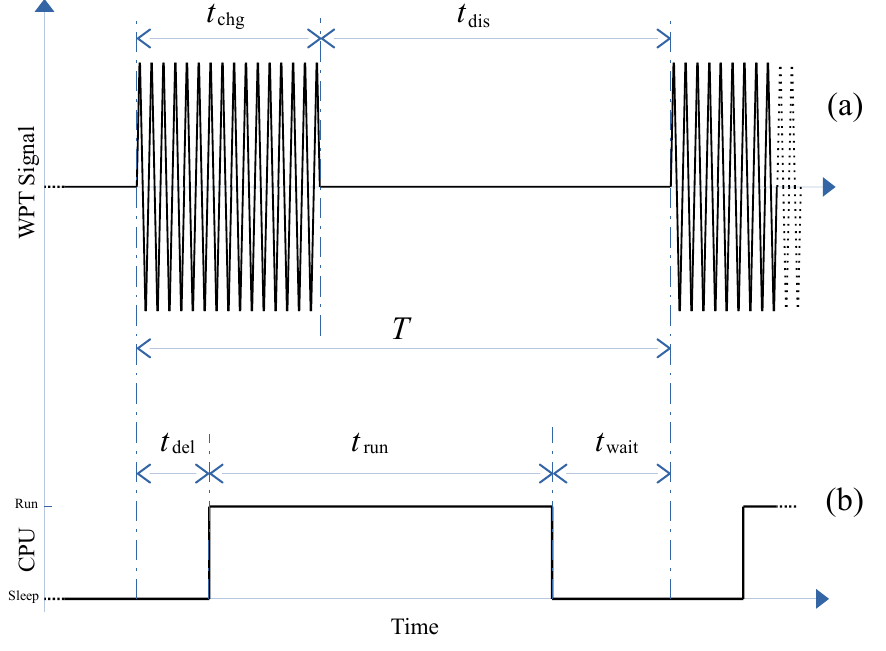
Figure 5. Sensor node using the ISO 11784/11785 standard: ( a ) wireless charging transfer signal and ( b ) underwater sensor node working